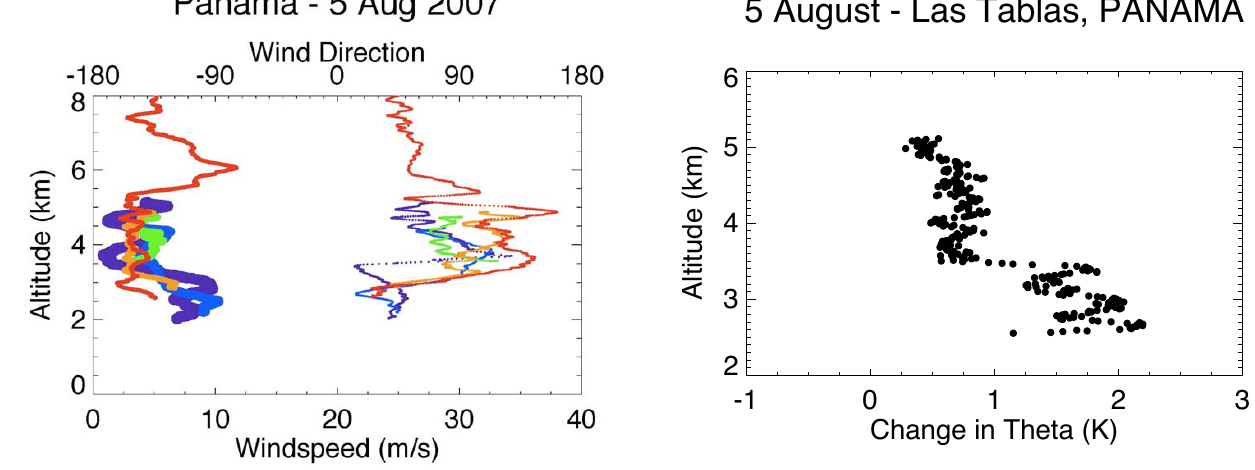
Fig. 8. Wind speed (thick) and direction (thin) as determined from the ozonesonde GPS data. The balloon moved through a region of vertical shear, resulting in the separation of the balloon trajectory from the trajectories of the air masses the sonde sampled. See text and Table 3 for further details.